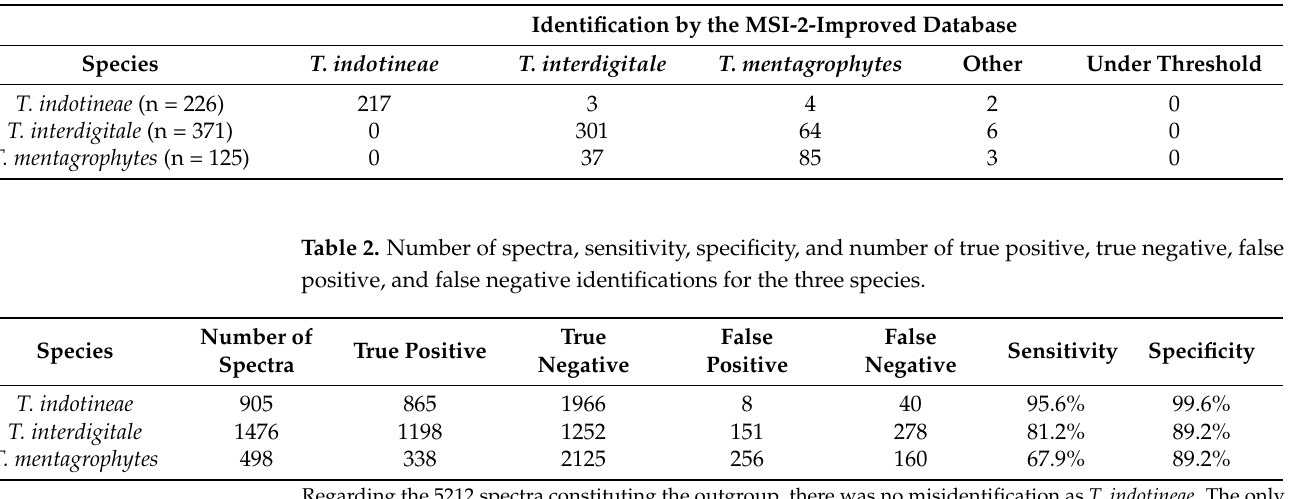
Table 1. Number of isolates of Panel 1 (best identification among the four replicates per culture condition) identified as T. indotineae , T. interdigitale , T. mentagrophytes , other species, or under the score threshold of 20 for the MSI-2-improved database.